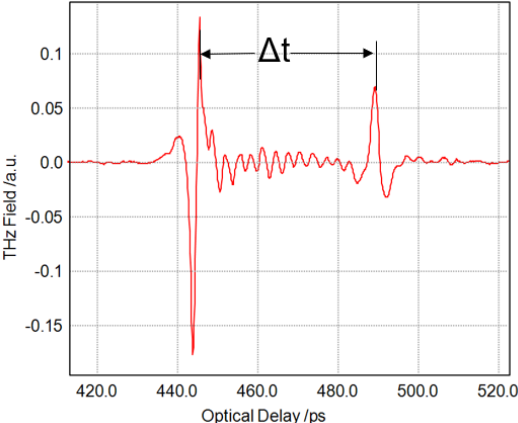
Figure 5. T − ray pulses from the transmitted GFRP composites ( n = 2.13 ∆ t = 42.7 ps, t = 3.0 mm).